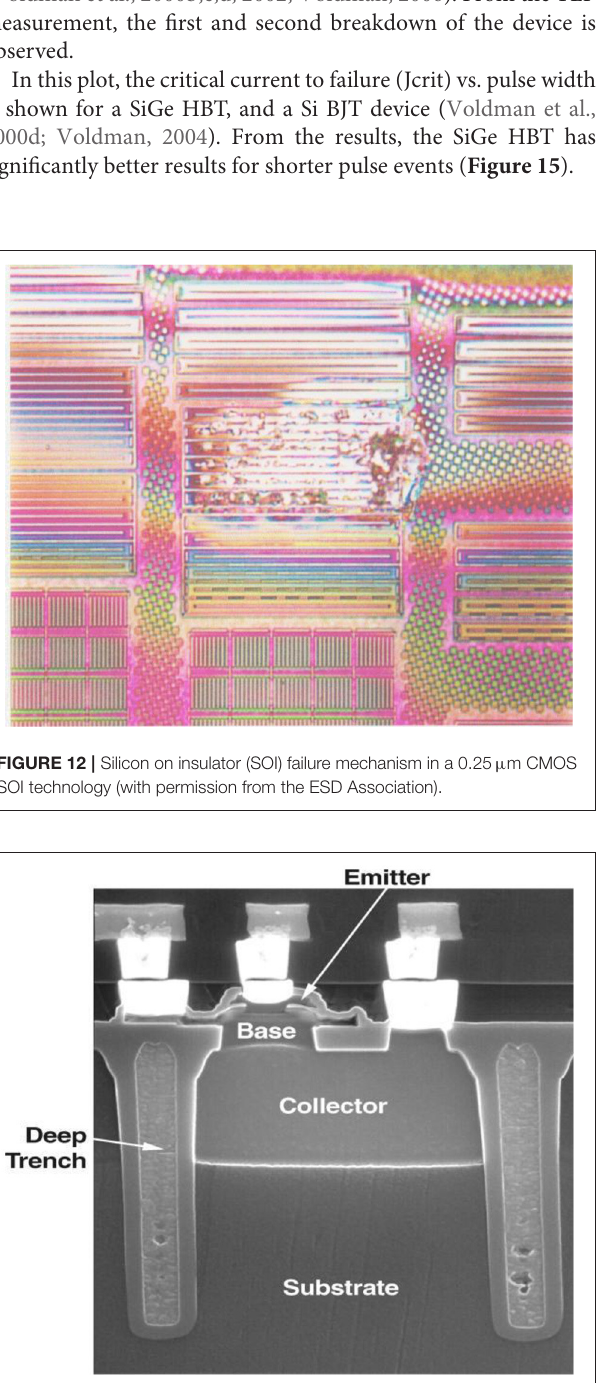
Frontiers in Materials |